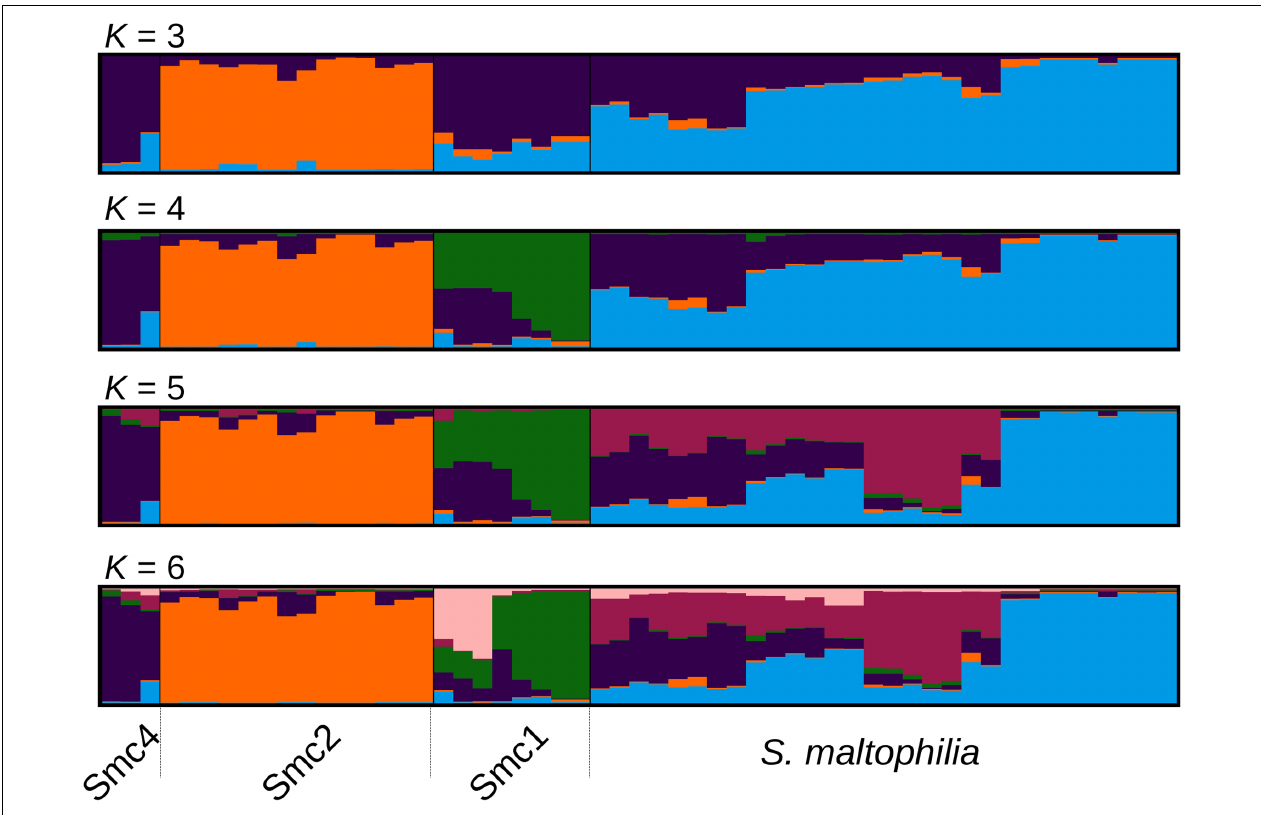
FIGURE 2 | Optimally aligned STRUCTURE barplots for 20 replicate runs executed for K = 3 to K = 6 generated with CLUMPAK, showing the population genetic structure of the Mexican isolates from the Smc classified as S. maltophilia (Smalt) Smc1 (Sm1) and Smc2 (Sm2). The Sm4 cluster corresponds to Smc4 sequences from pubmlst.org, included in the analysis as an outgroup to the Mexican Smc strains (see Figure 1B ).